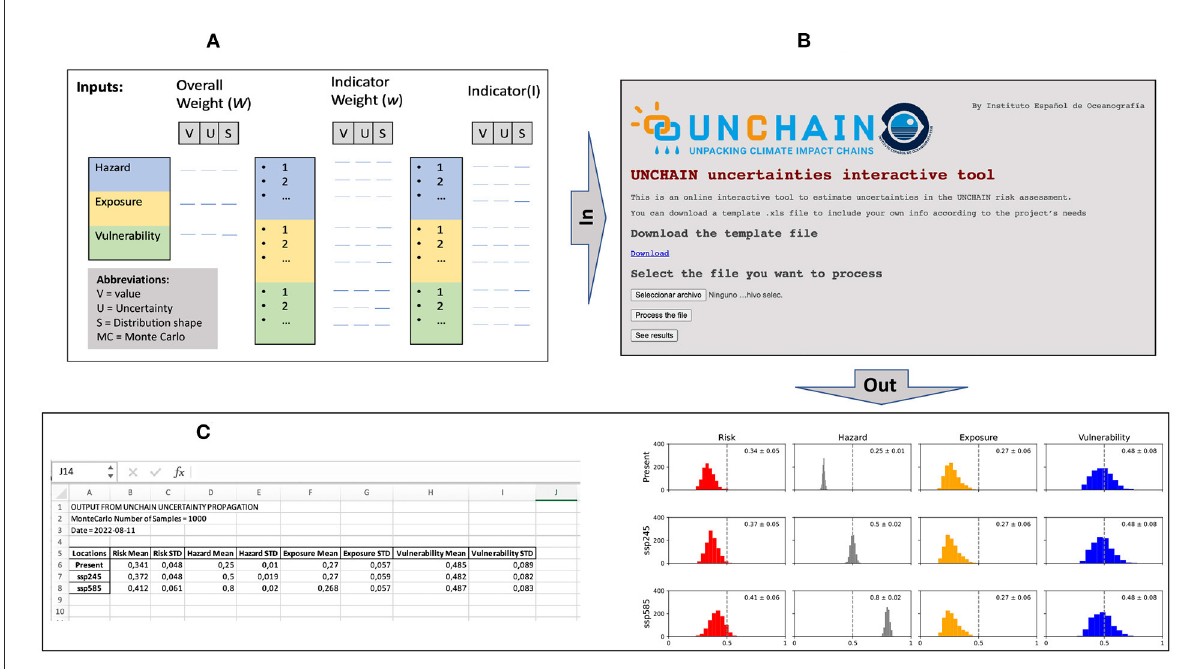
FIGURE3 Schematic representation of the UNTIC tool. (A) Panel illustrates the required input fields that are provided in the Excel spreadsheet. (B) Web interface. (C) Outputs: the UNTIC tool provides numerical and graphical outputs for the index composite and each of its components.